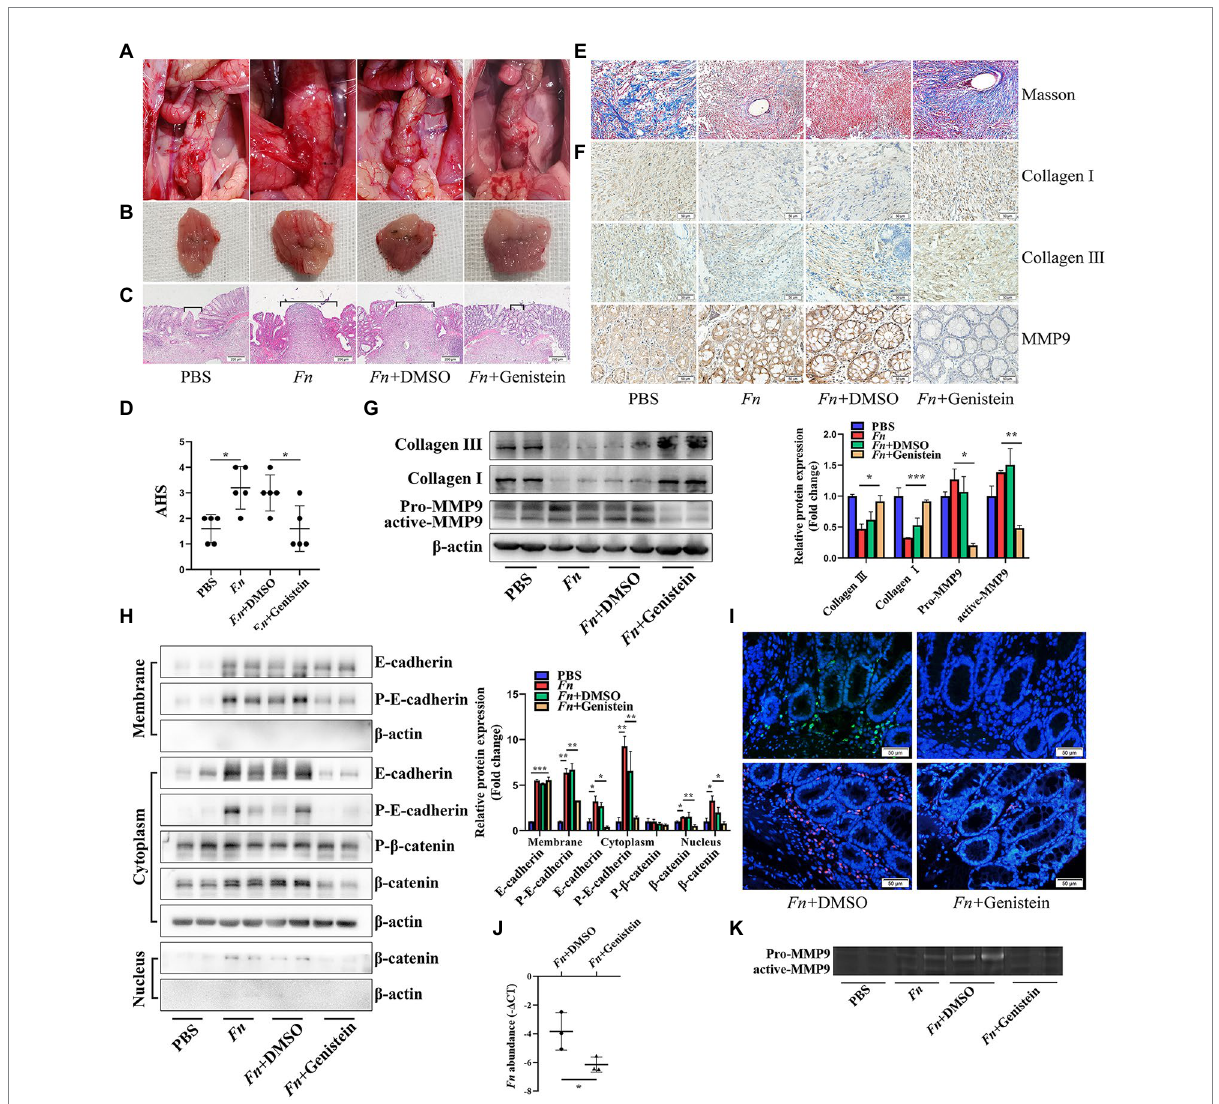
FIGURE 5 Fn promotes MMP9 expression and then leads to AL depending on the E-cadherin/ β -catenin signaling. (A) Gross inspection of the anastomotic healing. Genistein improves the Fn -mediated AL. (B) Excised and exposed suture lines of anastomotic sites. (C) H&E staining of anastomotic tissues. Brackets indicate the width of tissue apposition at the suture line (original magnification, 40×) (bar, 200 μ m). (D) The AHS of four groups (n = 5 per group). (E) Masson staining of anastomotic tissues demonstrates collagen depletion (original magnification, 200×) (bar, 50 μ m). (F) Immunohistochemical staining shows the expression of collagen and MMP9 (original magnification, 200×) (bar, 50 μ m). (G,H) The protein expression level of E-cadherin, β -catenin, collagen, and MMP9 in anastomotic tissues. Fn activates the E-cadherin/ β -catenin signaling pathway, stimulates the expression of MMP9, and contributes to collagen depletion. Genistein inhibits all Fn -activated functions. (I) FITC-labeled Fn (green) and Cy3-conjugated Fn (red) were used to detect the colonization ability (original magnification, 200×) (bar, 50 μ m). (J) qPCR demonstrates that genistein prevents Fn from adhering to the anastomotic sites. (K) Gelatin zymography demonstrates that genistein inhibits the Fn- activated MMP9 in anastomotic tissue. * p < 0.05, ** p < 0.01, *** p <